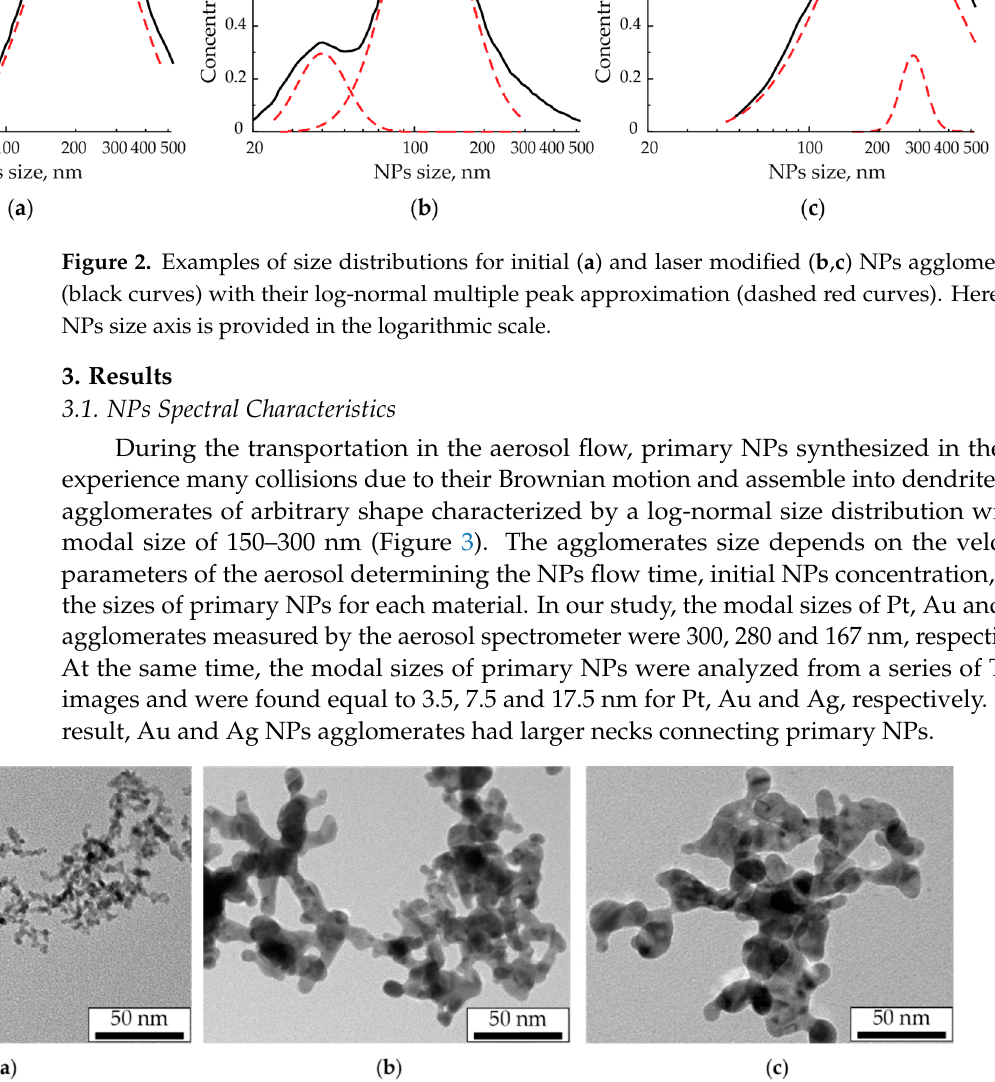
Figure 3. TEM images of Pt ( a ), Au ( b ) and Ag ( c ) NPs agglomerates.